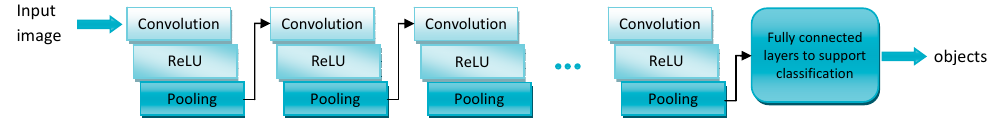
Figure 2. An illustration of the convolutional neural network structure.